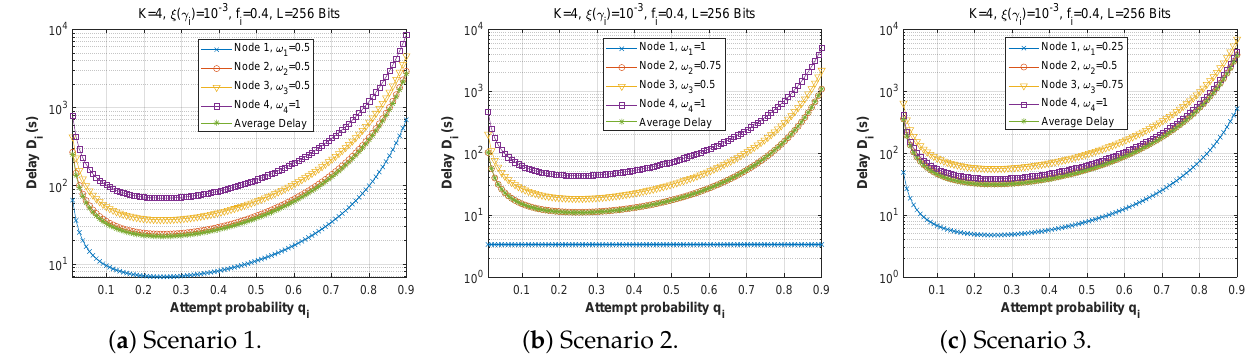
Figure 15. The delay experienced at each mobile device when varying the attempt probability with the arrival rate λ Q . i